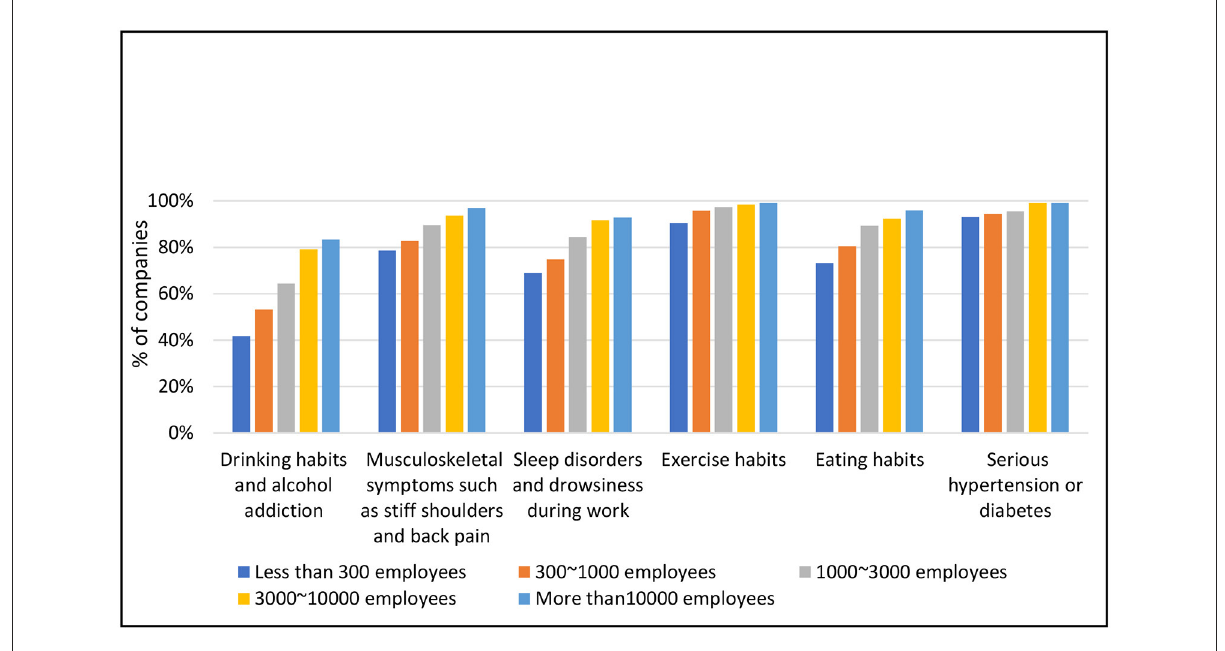
FIGURE6 Measures to help employees tackle the health